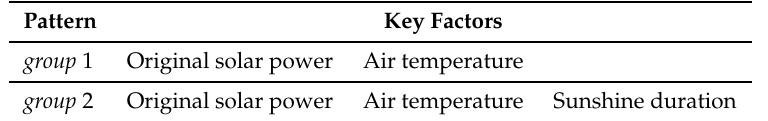
Table 2. The results of variable selection by LARS in NN.